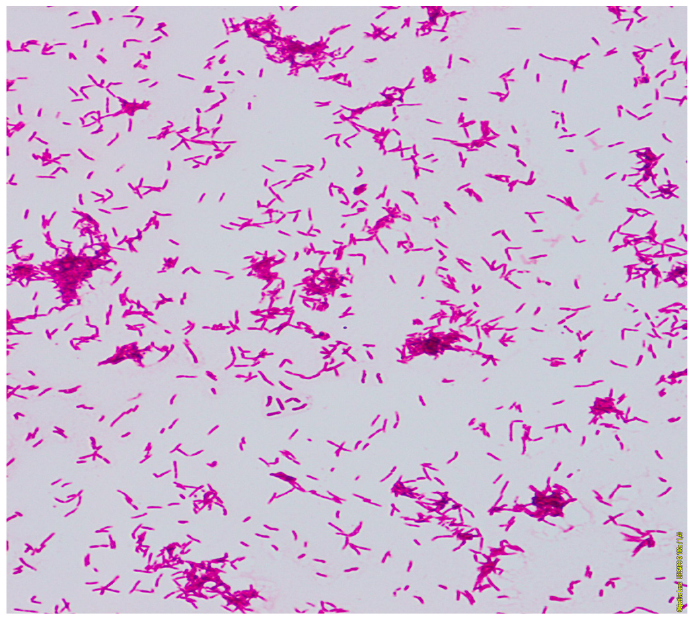
Figure 3. The acid-fast rods of mycobacterium. Smear made from a colony, Ziehl-Neelsen stain. The TBC ID MGIT (BD) identification test based on protein MPT64 production was